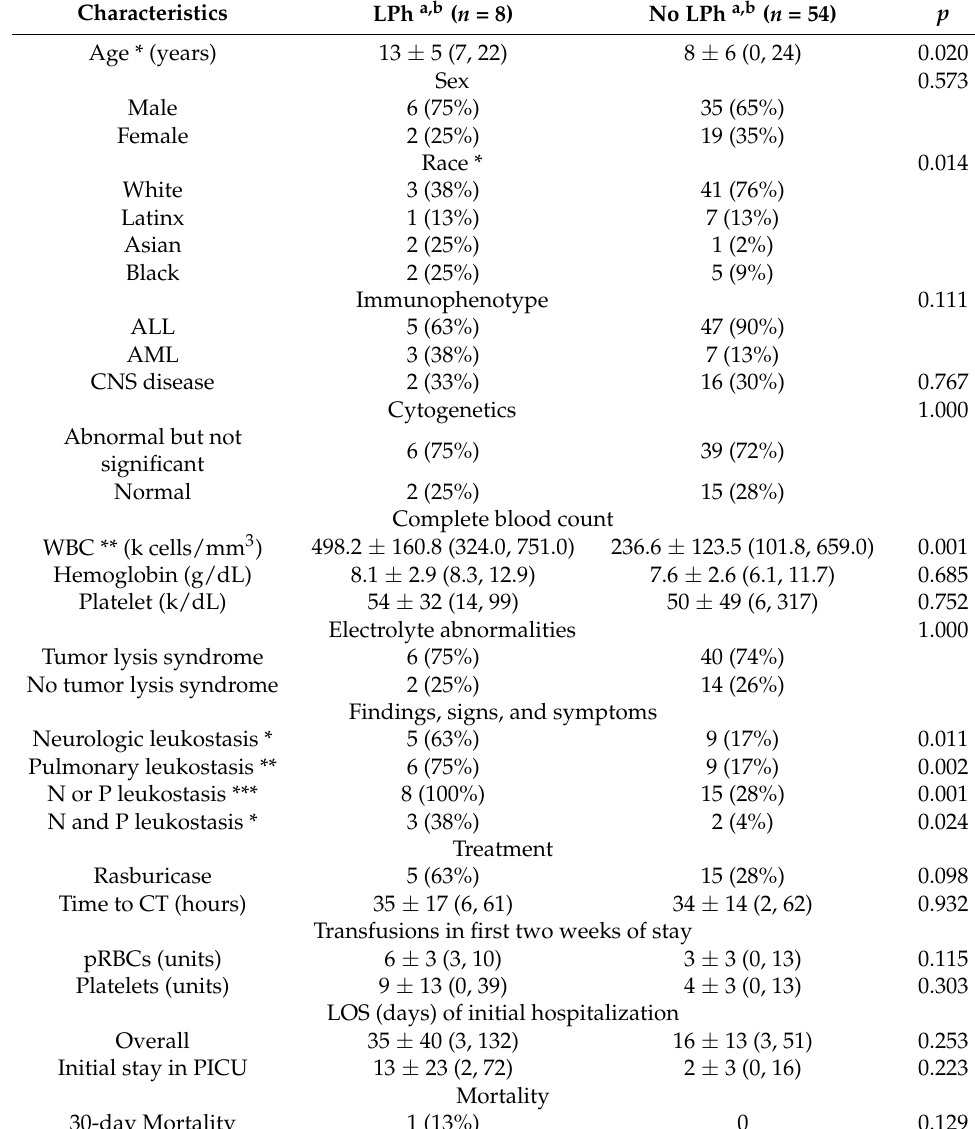
Table 1. Characteristics of patients who did or did not receive leukapheresis within 72 h of presentation.